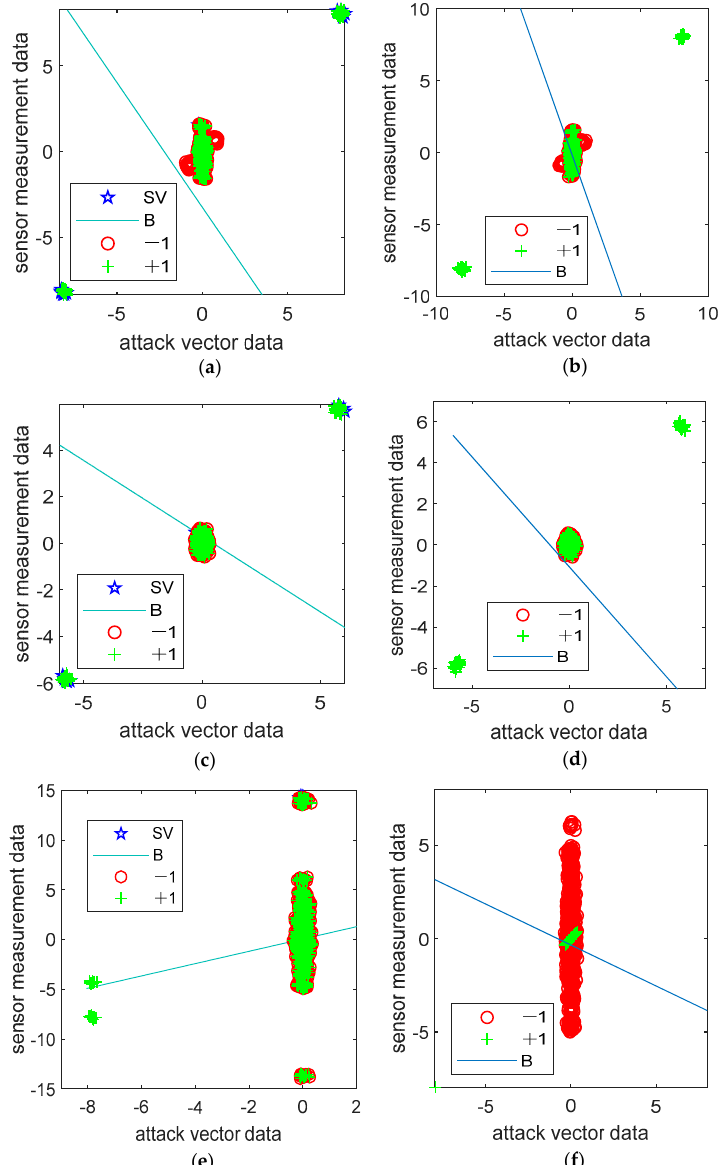
Figure 9. The machine learning methods’ performance in the detection of undetectable CCPAs ( a , c , e ) utilize SVM, while ( b , d , f ) utilize BP, for an IEEE 14-bus power system, an IEEE 30-bus power system, and an IEEE 118-bus power system, respectively.